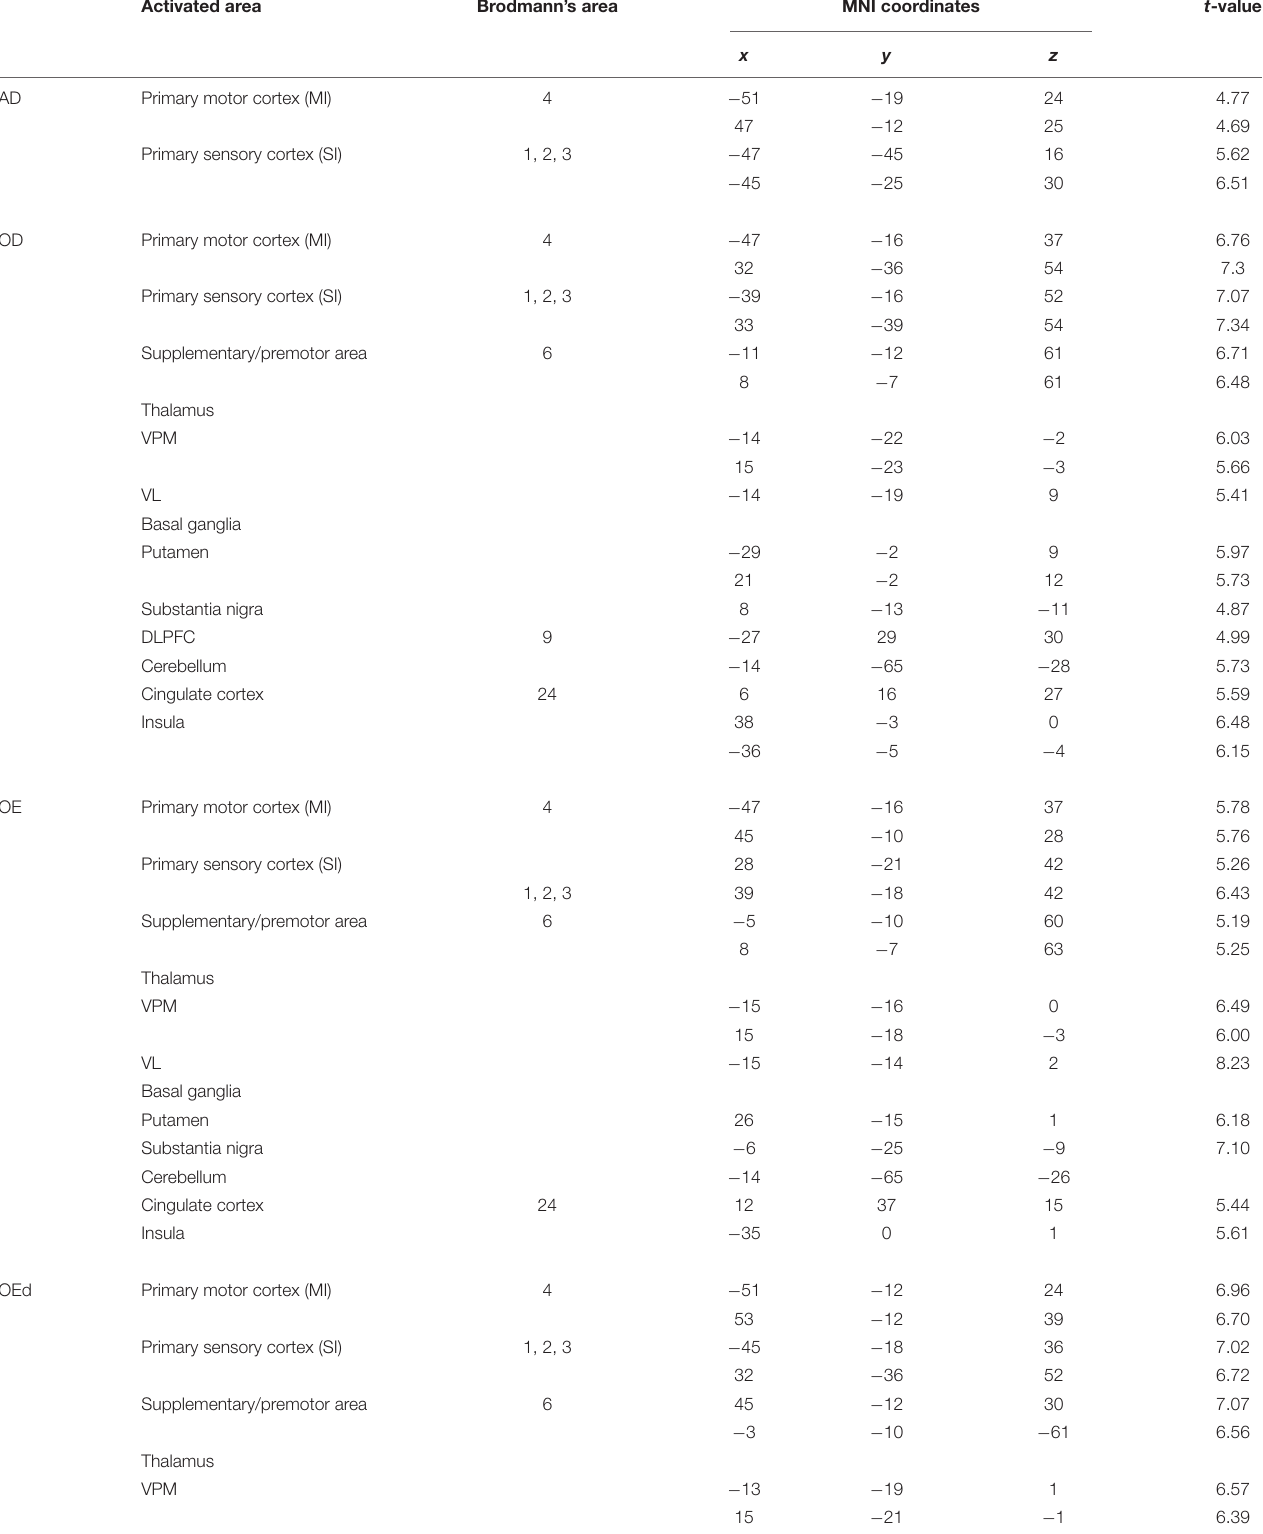
TABLE 1 | Significantly activated regions during tapping in the AD, OD, OE, and OEd groups. Activated area Brodmann’s